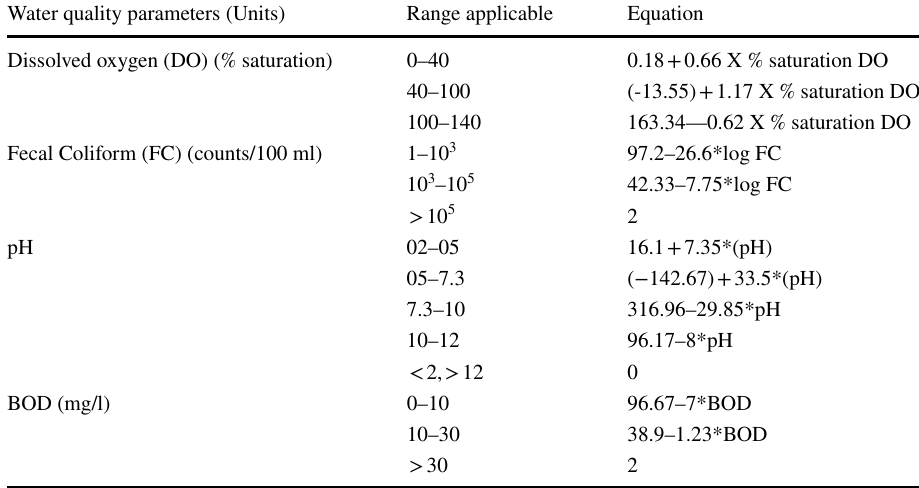
Table 2 Subindex equation used to calculate NSF WQI for DO, FC, pH and